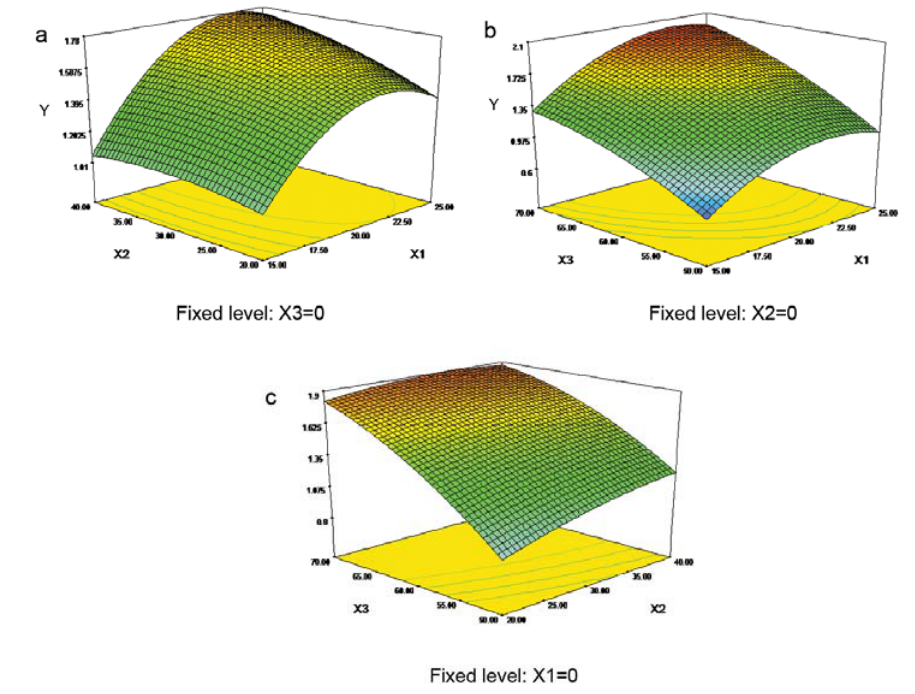
Figure 2. Response surface plots and contour plots showing the effects of variables : liquid:solid ratio, mL/g; x ( x 1 temperature,°C) on the response Y